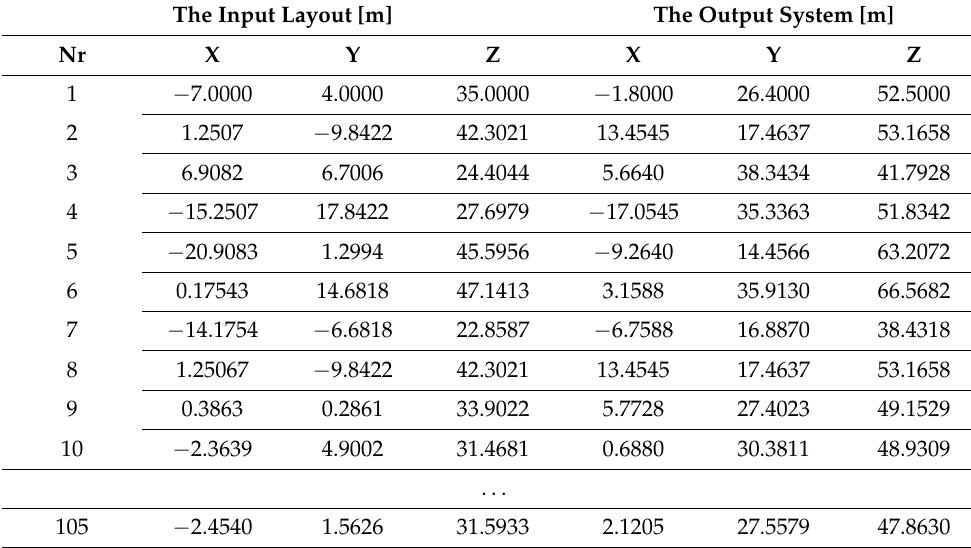
Table 1. Virtual point cloud in laboratory tests (selected